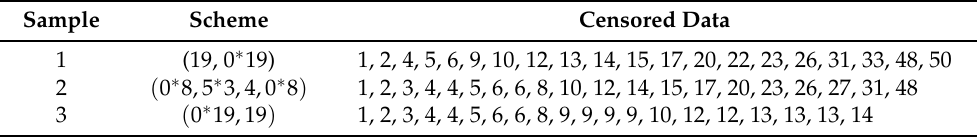
Table 8. Three PT-IIC samples from MVAD data. Sample